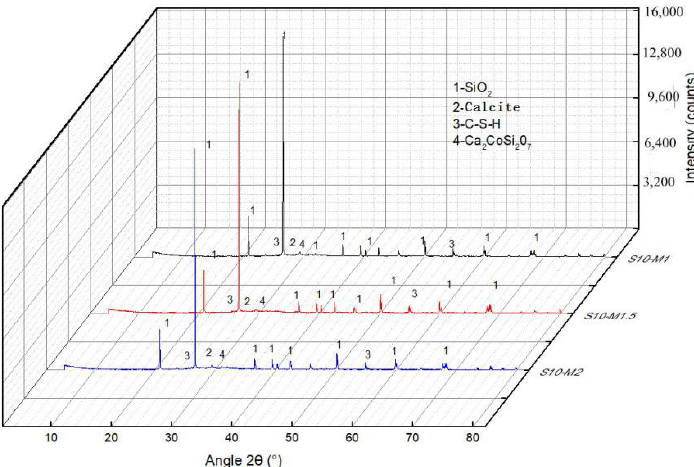
Figure 17. Effect of different contents of silicomanganese slag on the comparison of peak values of SiO 2 and C-S-H of samples.